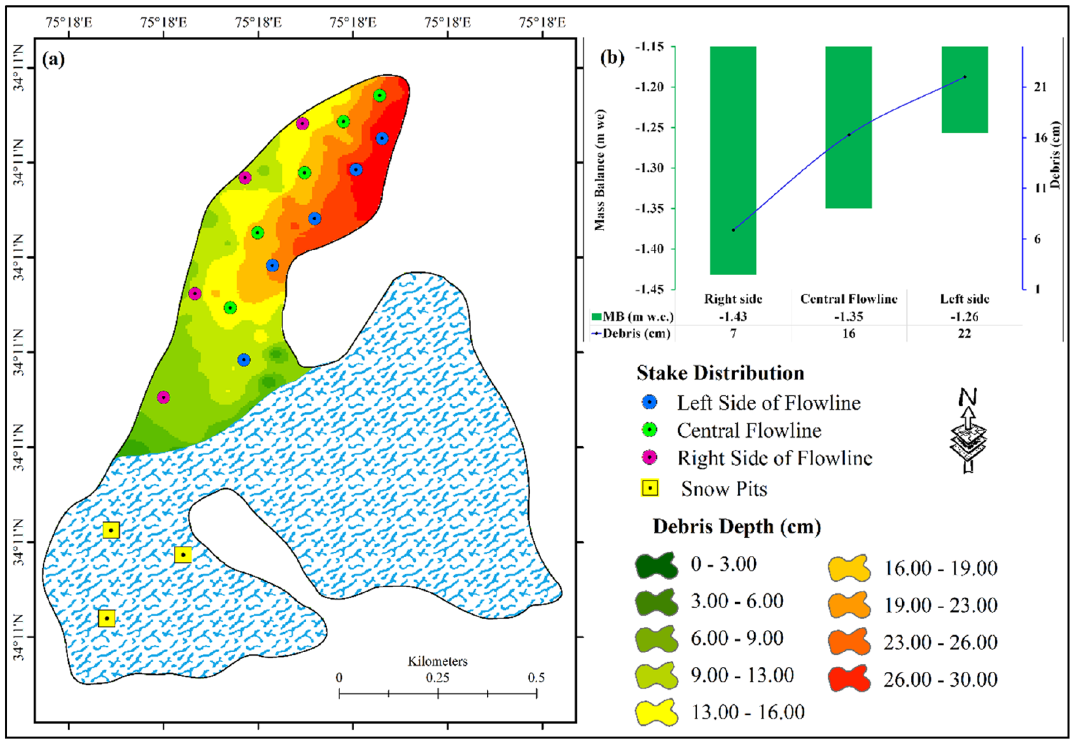
Figure 3. ( a ) Interpolated debris thickness map generated from the In-situ measurements, and ( b ) impact of debris thickness on mass loss of the Hoksar Glacier. Stakes when viewed facing the snout were categorized into stakes along the central flowline, stakes on the right side of the central flowline, and stakes on the left side of the central